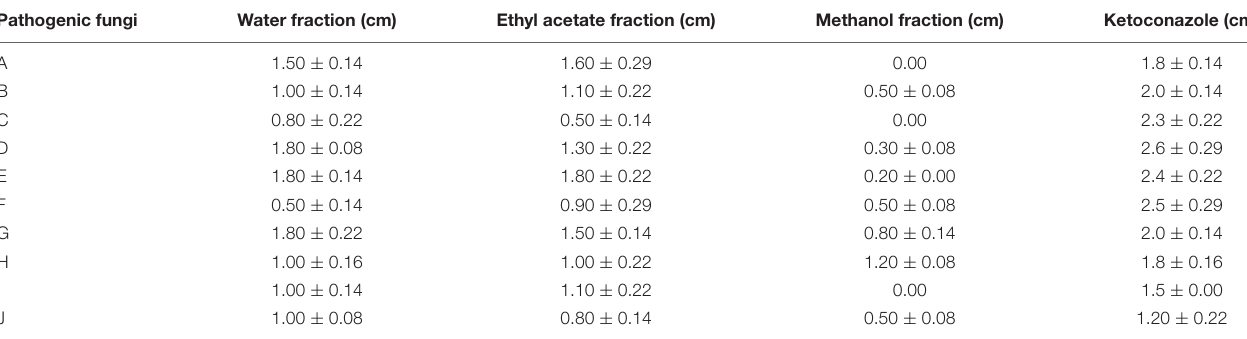
( Table 2 ), supporting the special inhibitory activity of DAPG against Fusarium